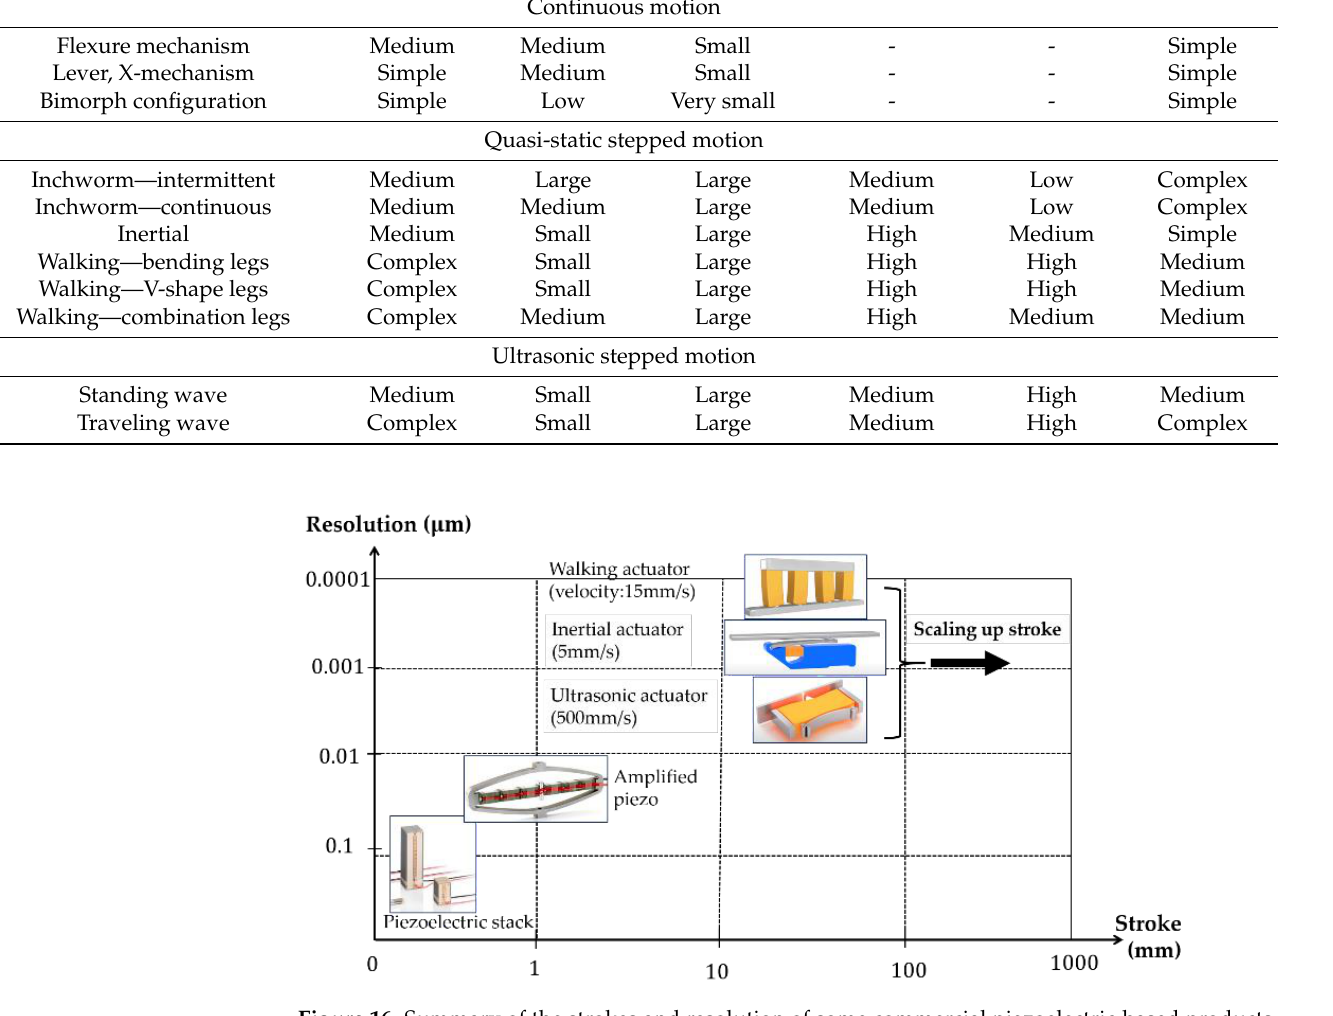
Figure 16. Summary of the strokes and resolution of some commercial piezoelectric-based products. The piezoelectric-hydraulic pump is another approach to amplifying the performance of the piezoelectric by coupling it with a working fluid. This pump, with a significant flow rate and stalled pressure, has been commercialized by Kinetic Ceramics company [164]. Several products from the solid-state pump series SSP can generate output pressure of 100